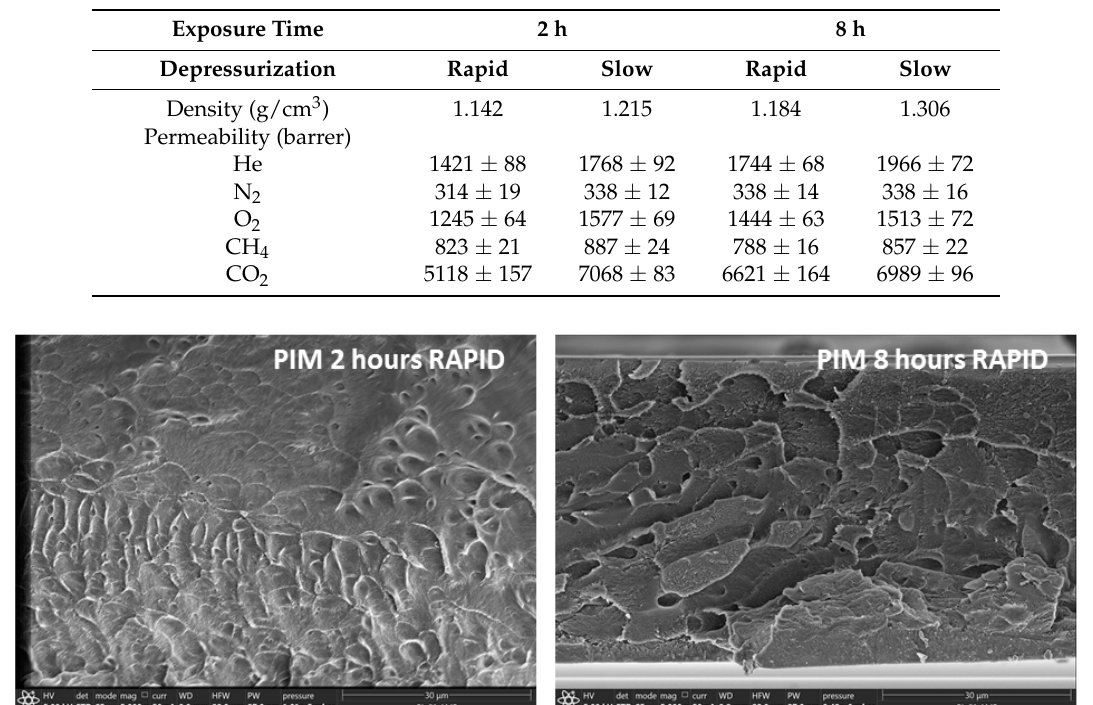
Table 4. Density (g/cm 3 ) and gas permeability (barrer) in supercritical CO 2 -treated PIM-1 membrane